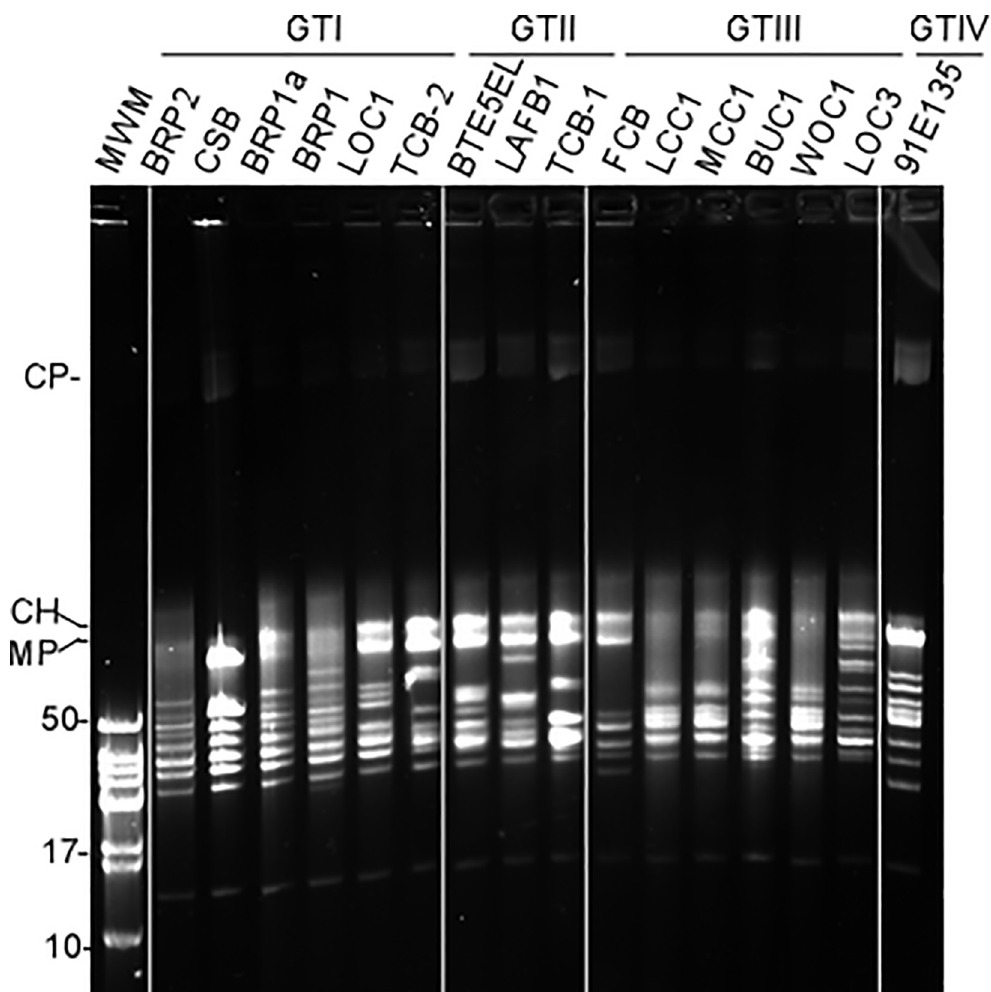
Fig 3. Plasmid profiles of 16 Borrelia turicatae isolates from Texas and Florida. Shown are previously reported and new isolates of Borrelia turicatae . The isolate designations are shown on top and are organized by genotype. Molecular size standards (MSS) in kilobases are shown on the left. CP: circular plasmid; CH: chromosome; MP: megaplasmid. Plasmid organization of B . turicatae GTIII indicated seven to 11 plasmids each ranging from ~13–100 kb. Plasmid profiles of PE1-926 were not included because we did not have bac- terial stocks to generate gDNA preparations. Plasmid maps of BUC1 and LOC3 were identical except that they contained a ~20 kb and 90 kb plasmid, respectively. Plasmid maps of LCC1, MCC1 and WOC1 isolates (obtained from same local area) indicated fewer plasmids with vari- ability in plasmid profiles compared to BUC1 and LOC3. They contained distinct ~38 and ~48 kb plasmids and lacked a ~24 kb, ~55 kb, and a ~60 kb plasmid. FCB isolate contained distinct ~20 kb, ~29 kb, ~38 kb, and a ~95 kb plasmids, while the ~13 kb, ~24 kb, and ~33 kb plasmids were similar in size to those detected in BUC1 and LOC3. GTIV consisted of 91E135, 95PE-570 and 99PE-1807 isolates and a plasmid profile for only the 91E135 isolate was evaluated because we did not have the bacterial stocks for the other two isolates to generate gDNA. From the analysis of 91E135, 11 plasmids were detected. Collec- tively, with all the isolates evaluated we observed considerable variability in number and size of linear plasmids.